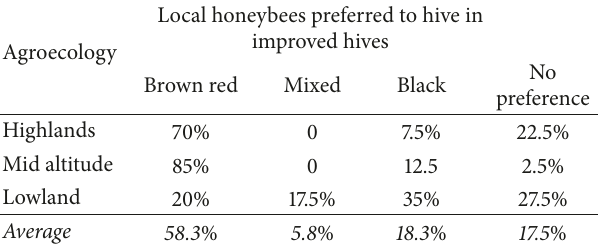
Table 4: Local honeybees preferred to hive in improved hives.